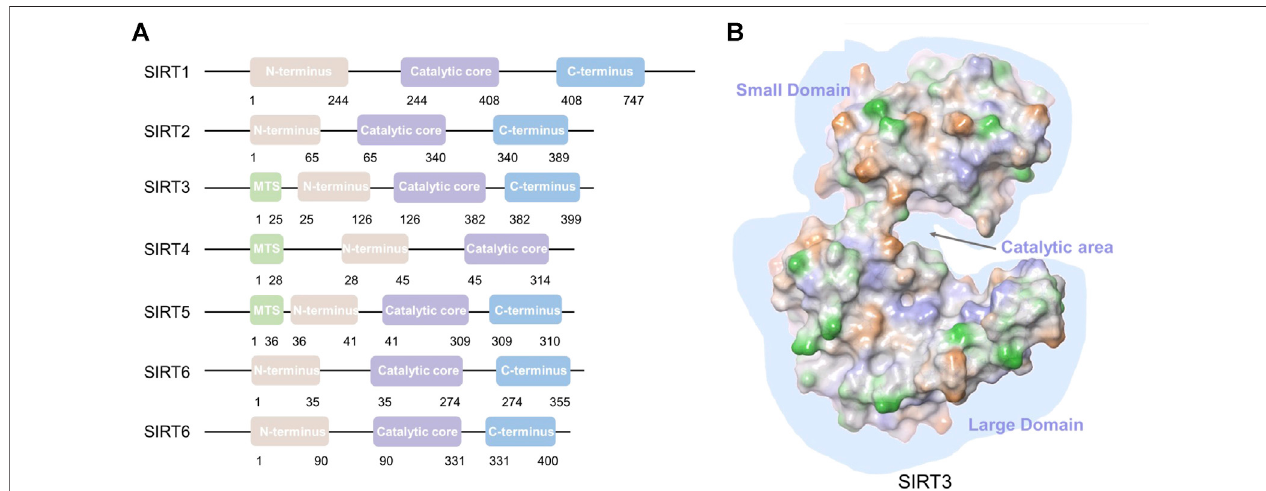
FIGURE1| SIRT1-7structuresandSIRT3domains. (A) SIRT1-7structure;mitochondrialtargetingsequence(MTS). (B) MajordomainsoftheSIRT3protein(PDB: 3GLS). A gap is formed between the small domain and large domain for substrate binding and catalysis.